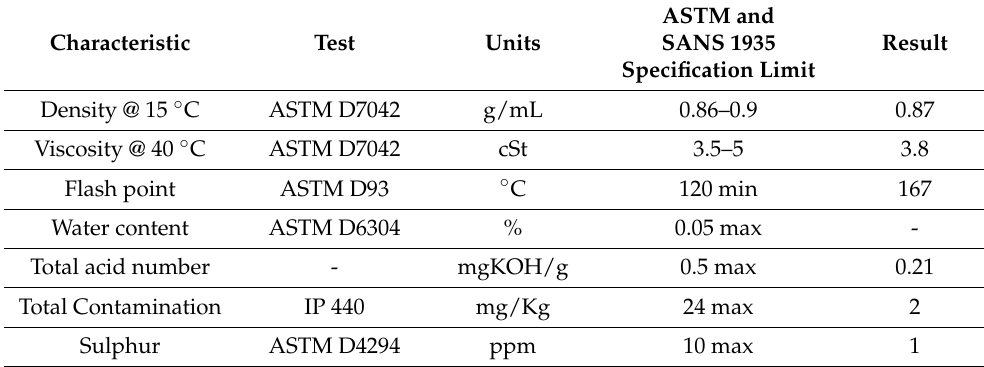
Table 6. Biodiesel synthesized in a membrane reactor using soybean oil as feedstock characterization [18].